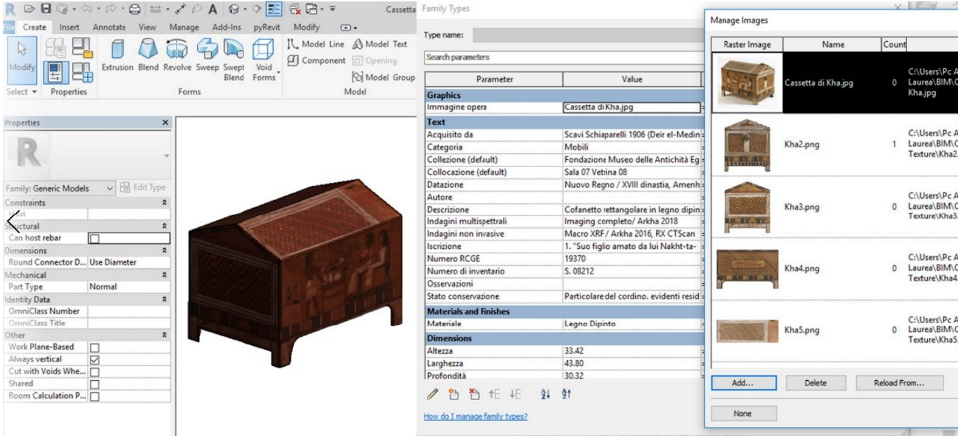
Figure 10. Collection models enriched by shared parameters. Cofanetto di Kha. Image by Arch. M. Cammarano.